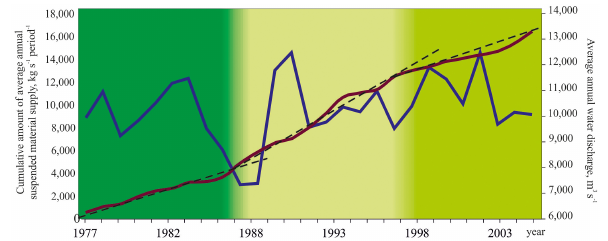
Figure 12. Long-term average annual discharge (blue line, right- hand axis) and the cumulative amount of average annual suspended sediments (red line, left-hand axis) over the period of instrumental observation. Dashed lines are trends of suspended sediments dis- charges for three periods with different annual water volumes (green